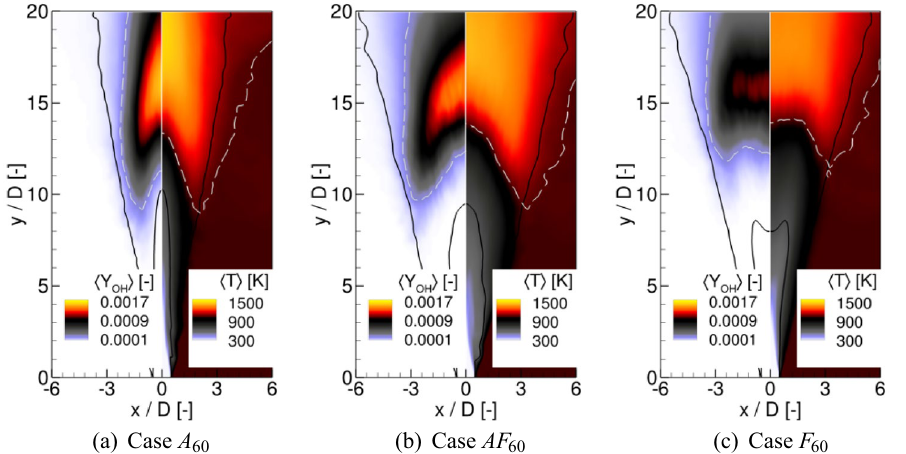
Figure 5. Contours of the time averaged OH mass fraction and temperature in the central ‘x-y’ cross-section plane.